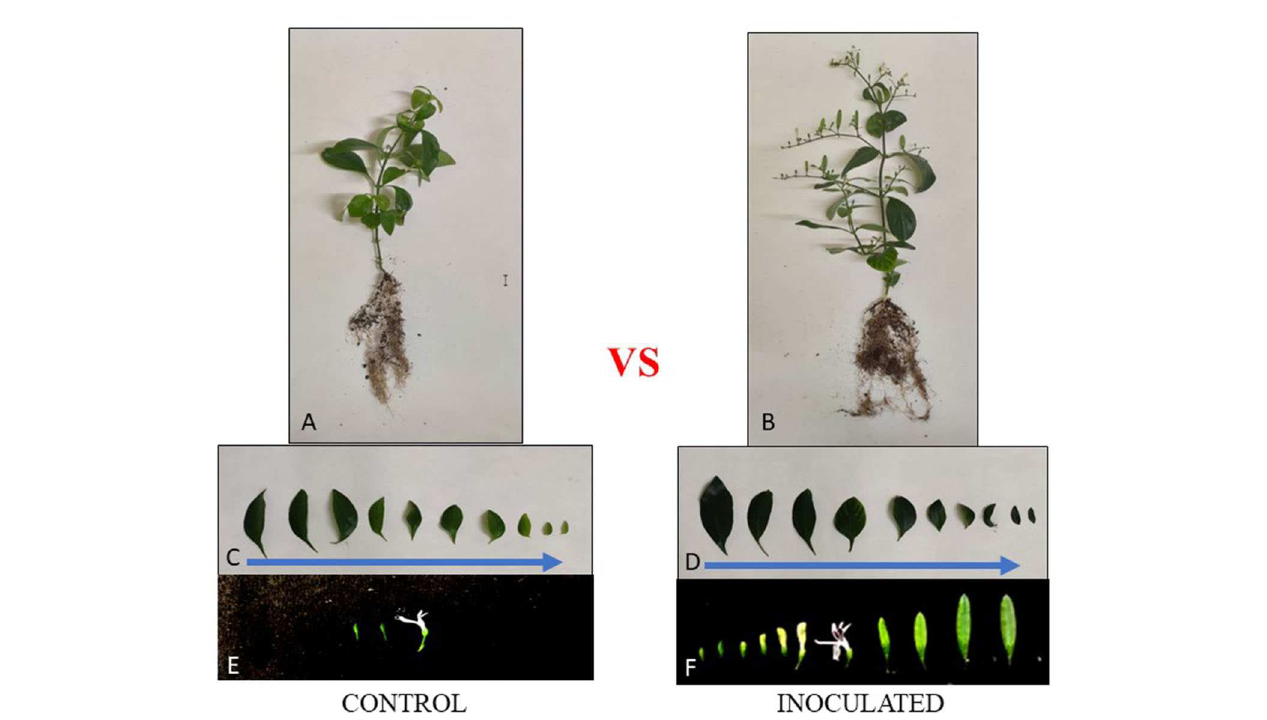
FIGURE6 Effect of bacterial isolate BC-II-20 inoculation in the morphology of root, shoot, and leaves in A. paniculata plants (A) control plants, (B) plants inoculated with bioinoculant (BC-II-20), and (C, D) comparison of leaf size in control (A) and inoculated (B) plants in the same plane in acropetal order. The representative construct/representation of a panicle in the inoculated plant (F) compared to the control plant (E) , the growth stages of flowers were arranged from top to bottom in an acropetal manner (older flowers at the bottom and younger at the top) in 60 days old plants.